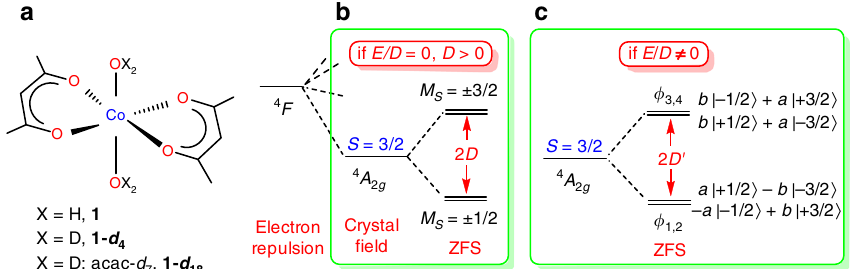
Fig. 1 1 , 1 - d 4 and 1 - d 18 and their ZFS. a Structures of 1 , 1- d 4 and 1- d 18 . b Ground-state quartet levels in high-spin, d 7 complexes with D 4 h symmetry ( D > 0; E / D = 0). c The quartet levels in 1 with lower symmetry [ E / D ≠ 0, D ′ = ( D 2 + 3 E 2 ) 1/2 ], where the mixing coef fi cients a = cos β and b = sin β are described by the mixing angle β obtained from the spin-Hamiltonian ( S = 3/2) with large D in the absence of fi eld 61,62 . Mixing depends on the rhombicity as tan 2 β = √ 3 ( E / D ) (SI of ref. 15